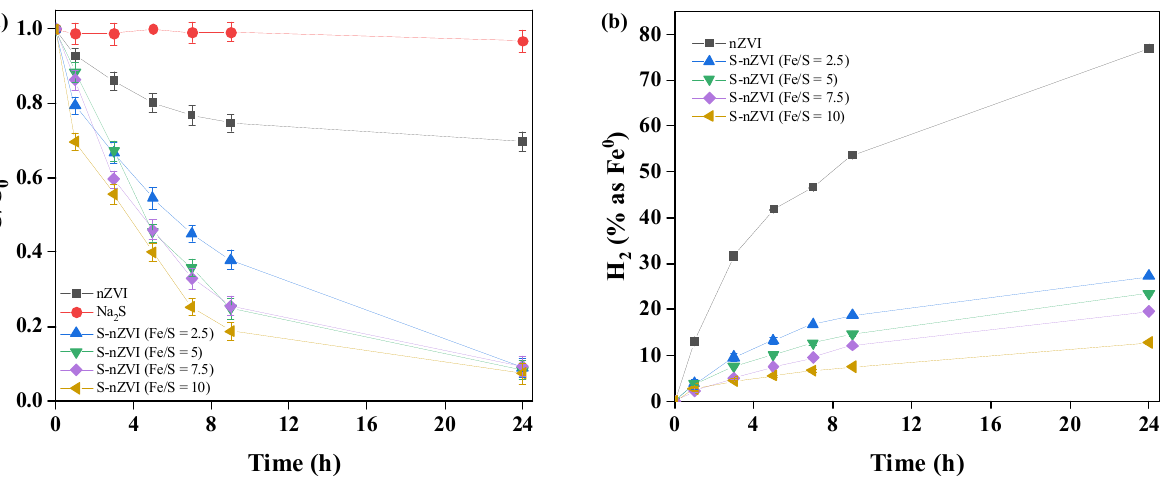
Figure 4. Performance of nZVI and S-nZVI materials with different Fe/S molar ratios in TCE degradation, ( a ) TCE removal; ( b ) H 2 evolution (pH: 7, t: 30 °C; S-nZVI: 0.026 g, TCE: 10 ppm).